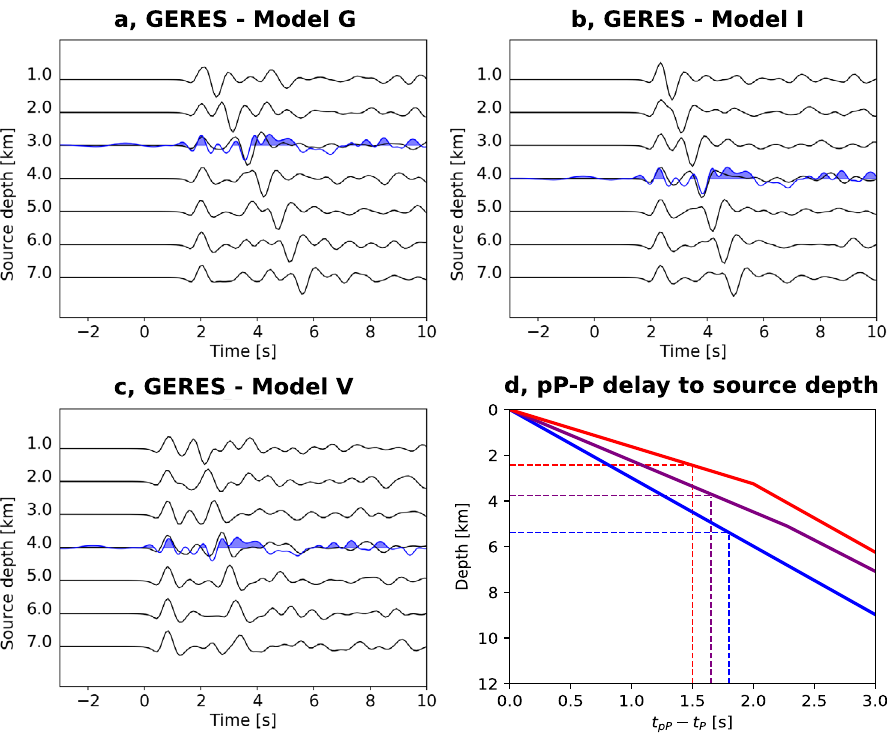
Fig. 4 Summary of seismic depth estimations for the October 1, 2013, 03:32:44 UTC, earthquake based on seismic array beam modeling. a – c Comparison of the observed (thick blue line) and synthetic (thin black lines) beams at the GERES arrays (Germany). Synthetics are computed for three velocity models (models G, I, and V in a – c , respectively), the preferred focal mechanism derived using model G (strike 41°, dip 56°, rake 4°), and depths between 1 and 7 km. Observed beams are plotted at the depths of 3 – 4 km, for which waveforms and P and pP pulses are best modeled. Both observed and synthetic beams represent normalized displacements, bandpass fi ltered in the range 0.25 – 1.80 Hz. d Theoretical source depth as a function of the pP delay for the three models at the source (model I in blue, model G in purple, model V in red): given the pP-P delay, and assumed a velocity model, we can estimate the depth. We consider delays of 1.5 – 1.8 s, as picked from beams at GERES, Germany and ILAR, US arrays, and an average of 1.65 s. Three scenarios are shown (dashed lines), leading to a depth of 2.4 (red line), 3.8 (purple line), and 5.4 (blue line)